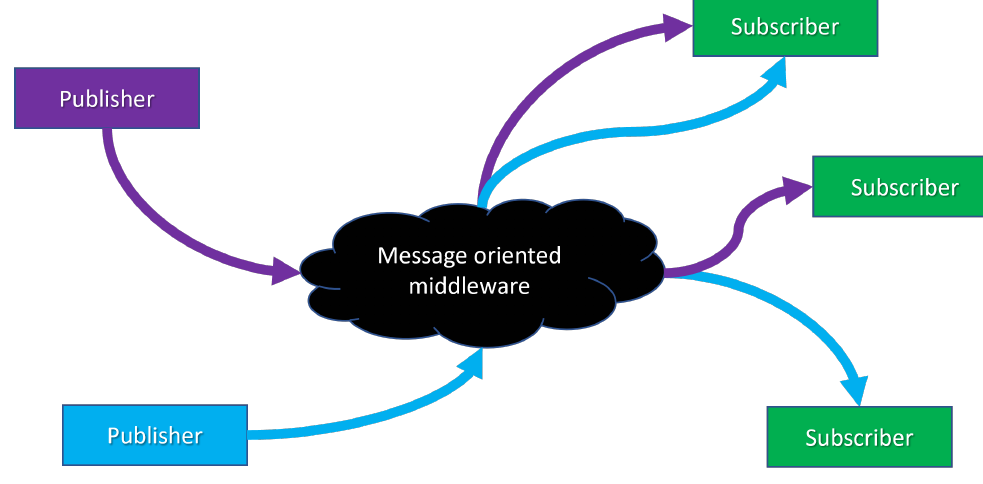
Figure 2. OPC UA PubSub